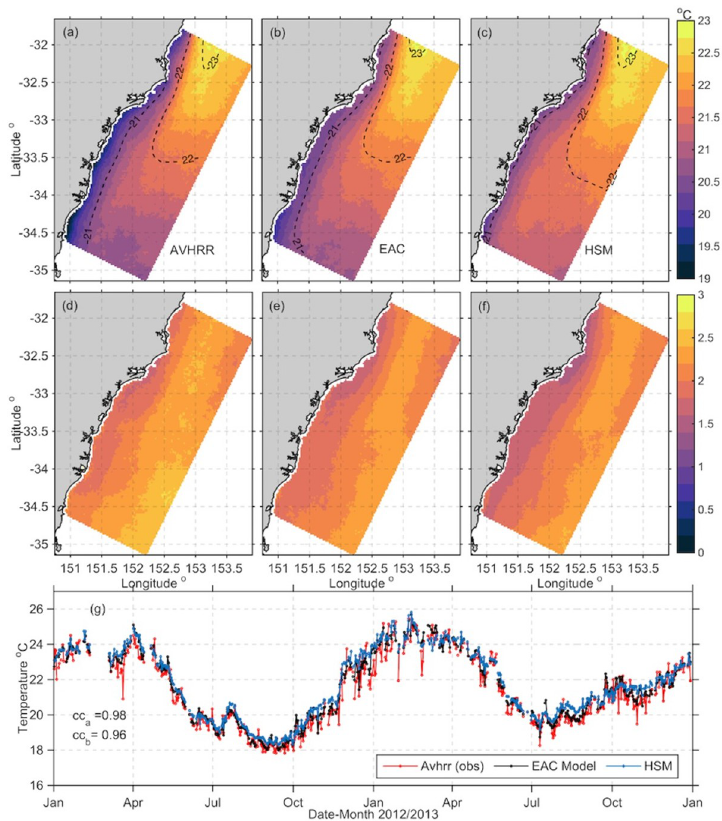
Fig 2. Domain wide 2-yr mean sea surface temperatures (SST) in o C (top row) and their associated standard deviations (middle row) from (a) AVHRR L3S satellite data, (b) EAC model, (c) HSM. Associated standard deviations are shown in (d-f). (g) Time series of spatially averaged SST ( o C) across the domain for time periods with 15% or more satellite (AVHRR) data over the 2 years. Correlation coefficients are shown where cc a is the correlation between the satellite and EAC model SST and cc b is the correlation between the satellite and HSM